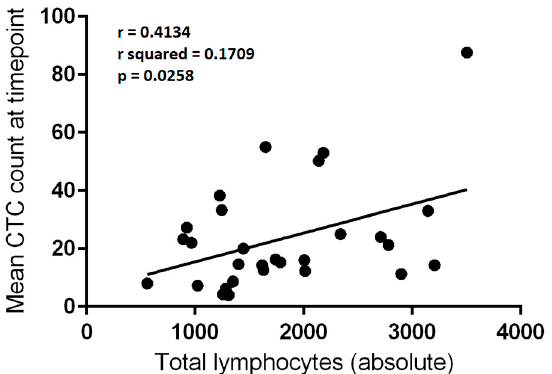
Figure 1. Correlation between absolute total lymphocyte count (per μ L) and mean circulating tumour cell (CTC) count per 3 mL of blood at a given blood draw ( n = 29). Linear regression, r = 0.4134; r 2 = 0.1709; p = 0.0258.